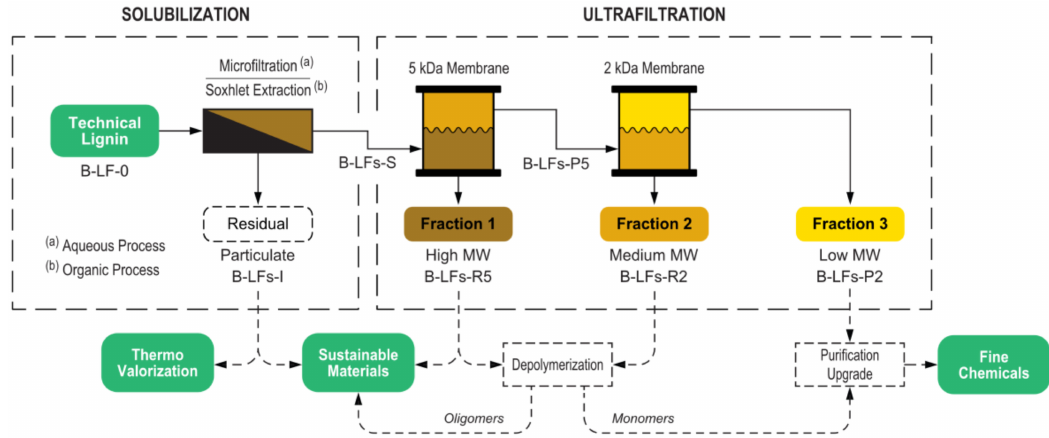
Figure 1. Overview of the overall fractionation process. Possible applications of obtained fractions and related downstream processes are indicated in the bottom line (dashed arrows).